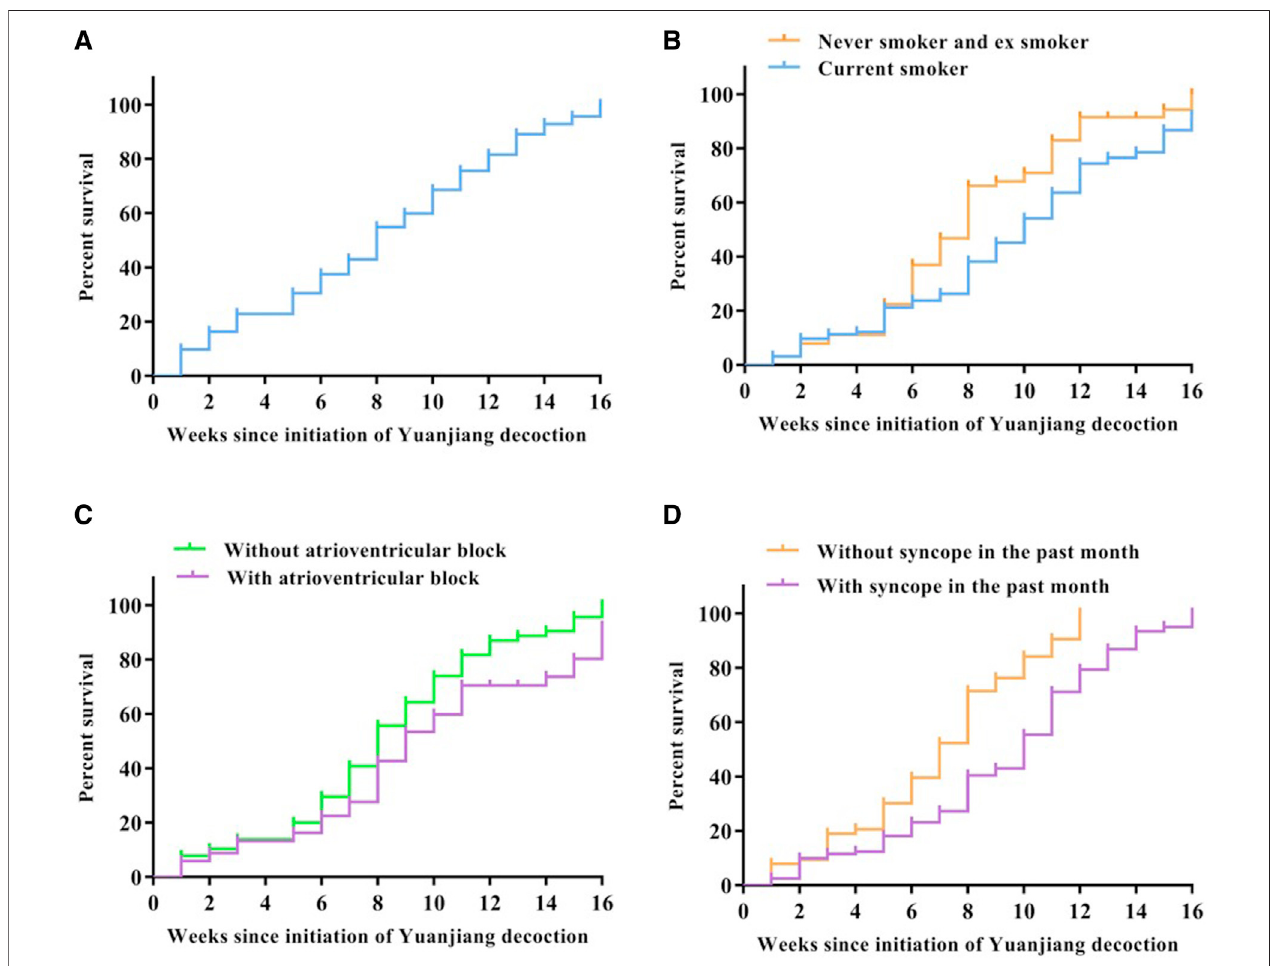
FIGURE5| Cumulativeincidenceofclinicalimprovement.Clinicalimprovementisshowninthefullcohort (A) ,inthecohortstrati fi edbysmokingstatus[ (B) , p =0.013], in the cohort strati fi ed by atrioventricular block [ (C) , p = 0.017] and in the cohort strati fi ed by syncope in the past month before treatment [ (D) , p = 0.032].